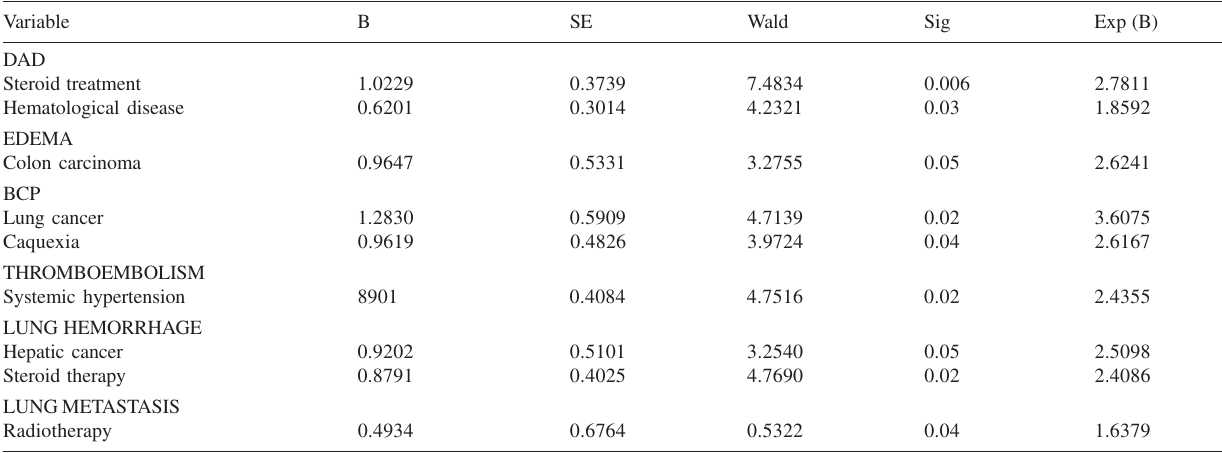
the underlying disease Variable B